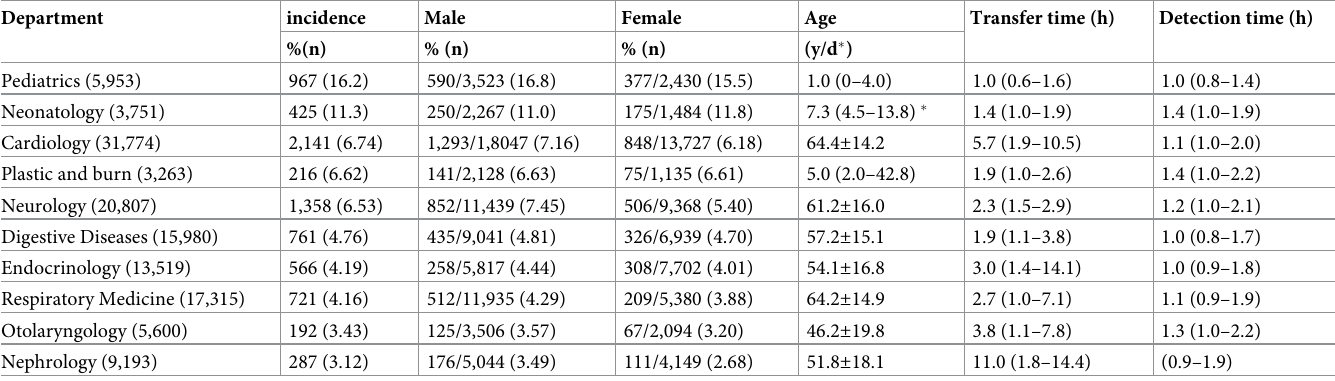
Table 2. Incidence of hemolysis in the top 10 clinical departments (n = 127,155).